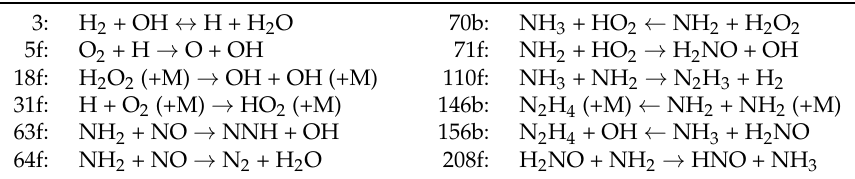
Table 1. The reactions most significant to the dynamics of the autoignition